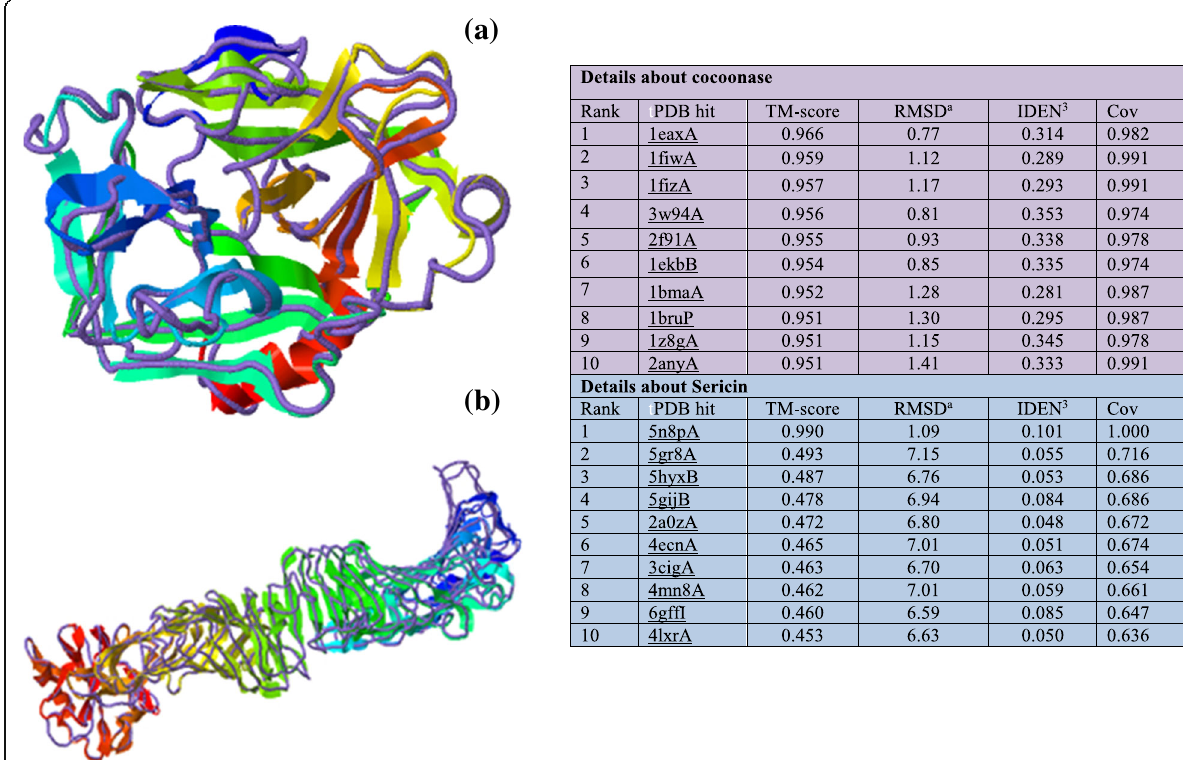
Fig. 5 The structure alignment of both proteins like cocoonase ( a ) and sericin ( b ), between the first I-TASSER model and the top 10 most similar structure template in PDB. Ten PDB structures were predicted nearby to the target. The structure of the first I-TASSER model (shown in rainbow cartoon) is superimposed on the parallel structures from the PDB (shown in purple backbone touch). The structure similarity between the objective model and the 10 nearest proteins is positioned by